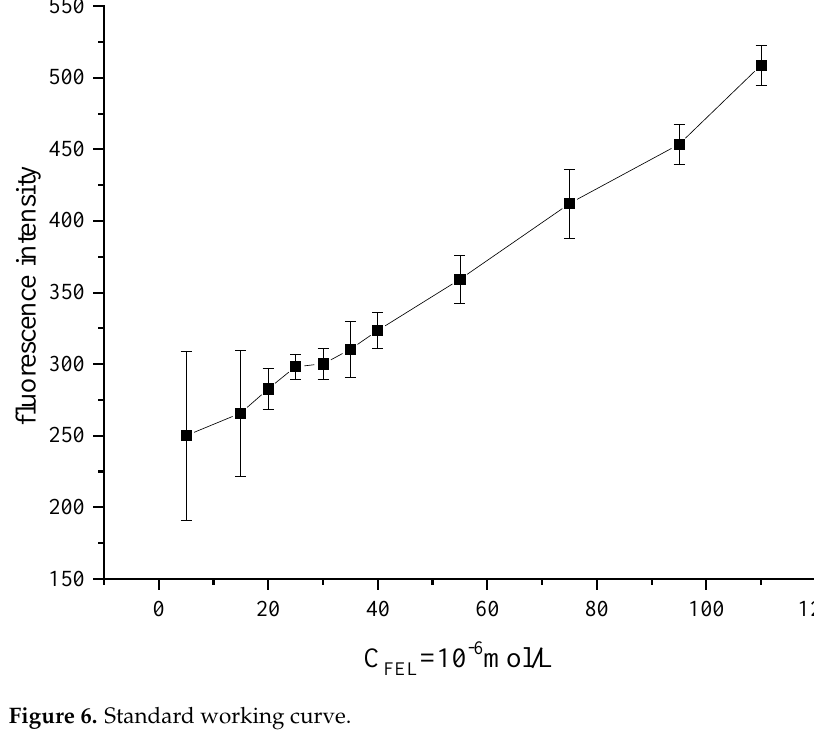
Figure 6. Standard working curve.